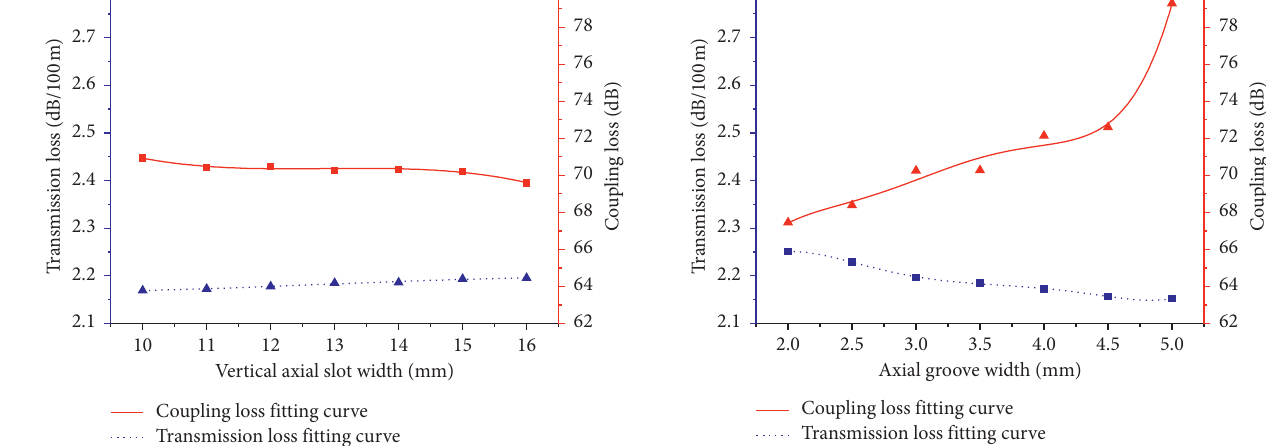
Figure 7: The relationship between the axial slot width of U-groove and the loss of leakage cable.